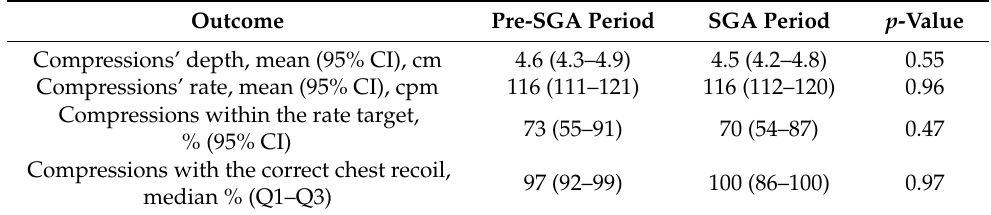
Figure 2. The proportions of the compressions with the correct depths by period ( p = 0.99). There were no significant differences in the secondary outcomes between the two periods (Table 1). Table 1. The secondary outcomes.